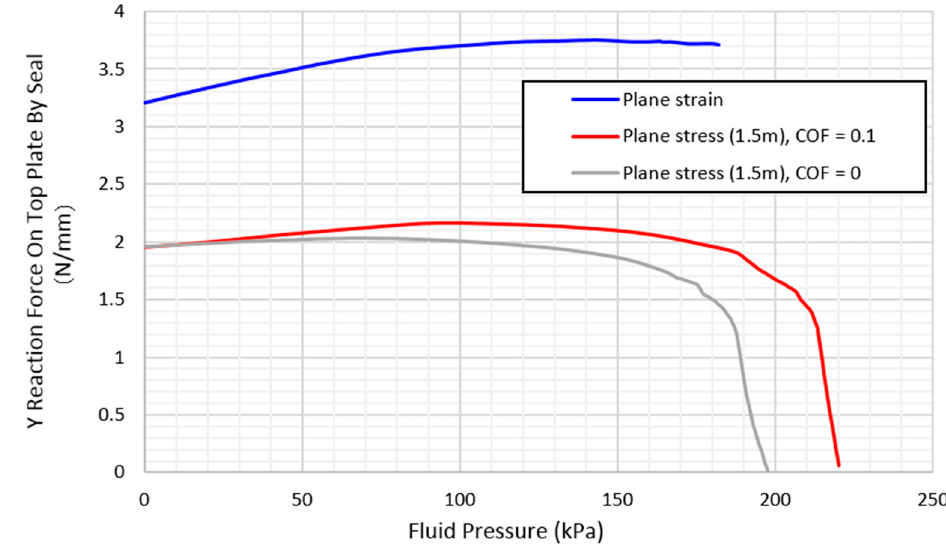
Figure 13. Effect of modeling parameters on results.